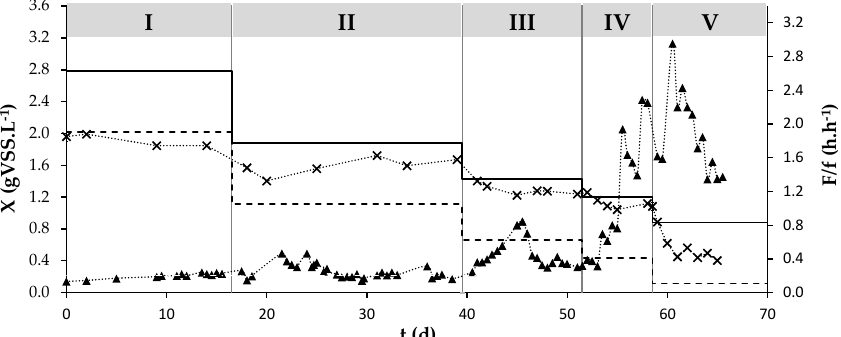
Figure 1. Biomass concentration ( X , × ) and feast/famine ratio ( F/f , (cid:78) ), over time, in the selection SBR, operated under the five operational periods (I-IV), and representation of the calculated X, if the total nitrogen ( solid line ) and all the ammonia–nitrogen ( dashed line ), present in the feed, were used for cellular growth.